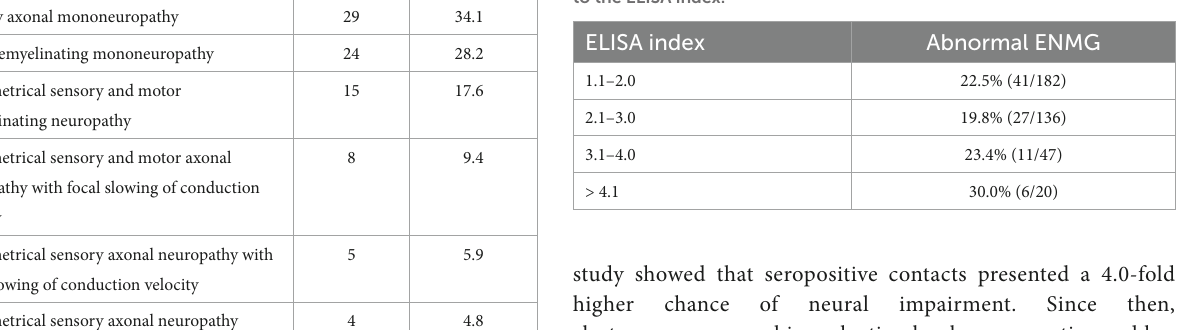
TABLE 4 Proportion of electroneuromyographic impairment according to the ELISA